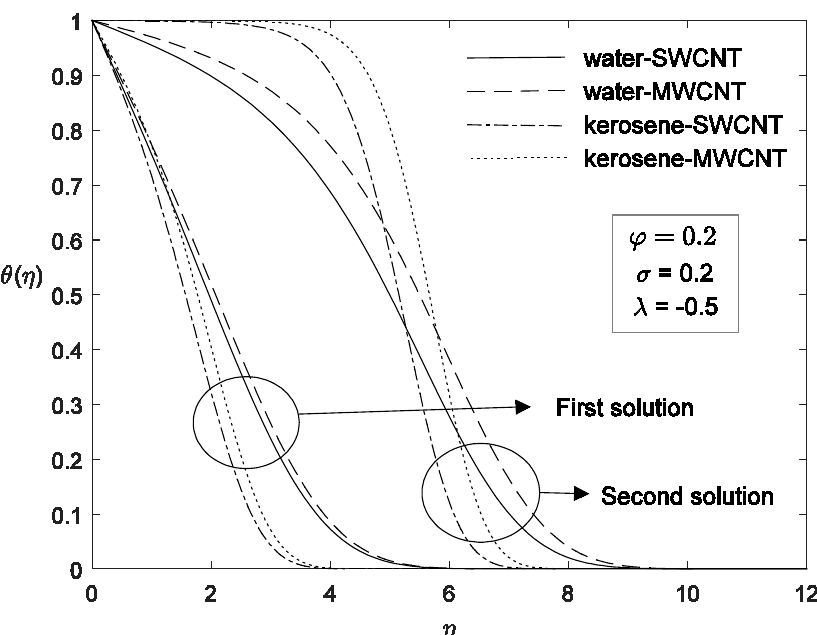
Figure 23. Effect of various nanoparticles on temperature profile.